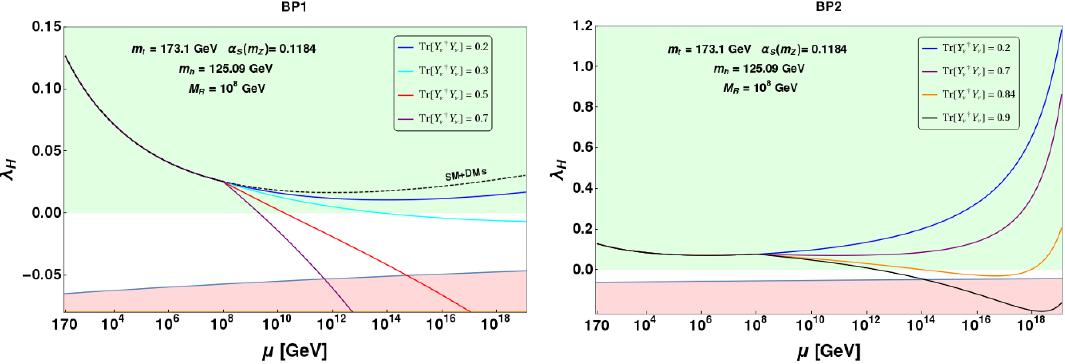
Figure 20 . RG running of (cid:21) H with energy scale (cid:22) for di(cid:11)erent values of Tr[ Y y di(cid:11)erent colours and values are mentioned in the (cid:12)gure inset) for the benchmark points BP1 (left) and BP2 (right). Here we have chosen M R = 10 8 GeV for illustration. The black dotted line here corresponds to the case when right handed neutrinos are absent in this